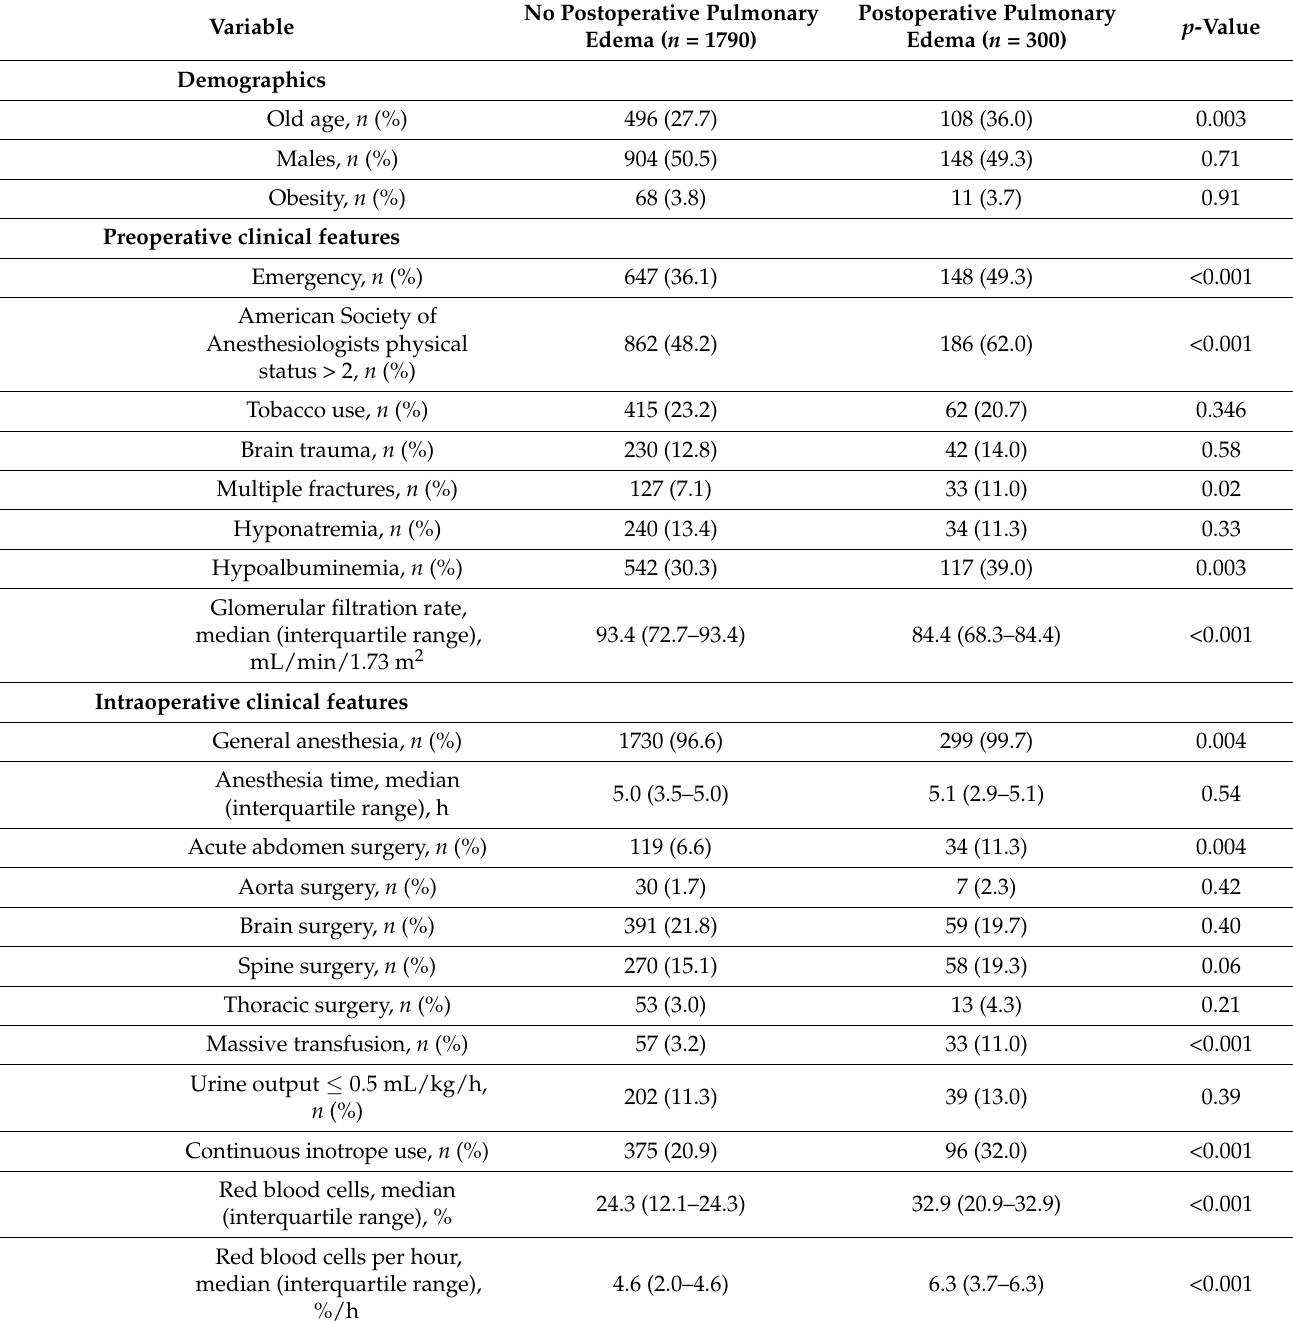
Table 1. Demographic and clinical data of postoperative pulmonary edema